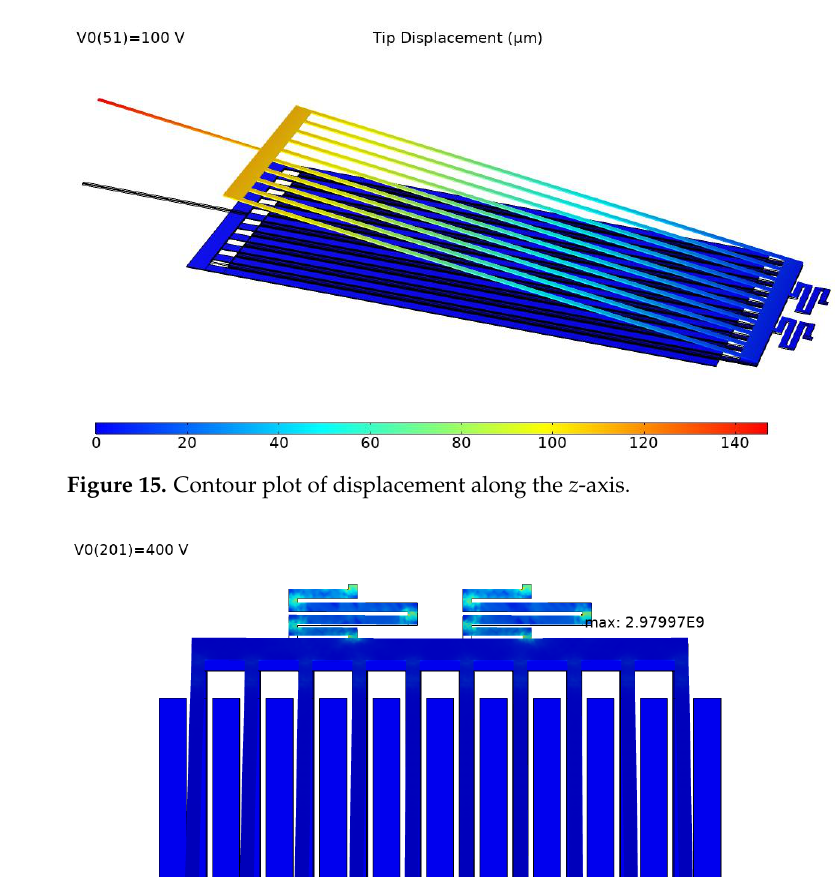
Figure 16. Stress analysis result of the microgripper with the applied voltage of 400 V.